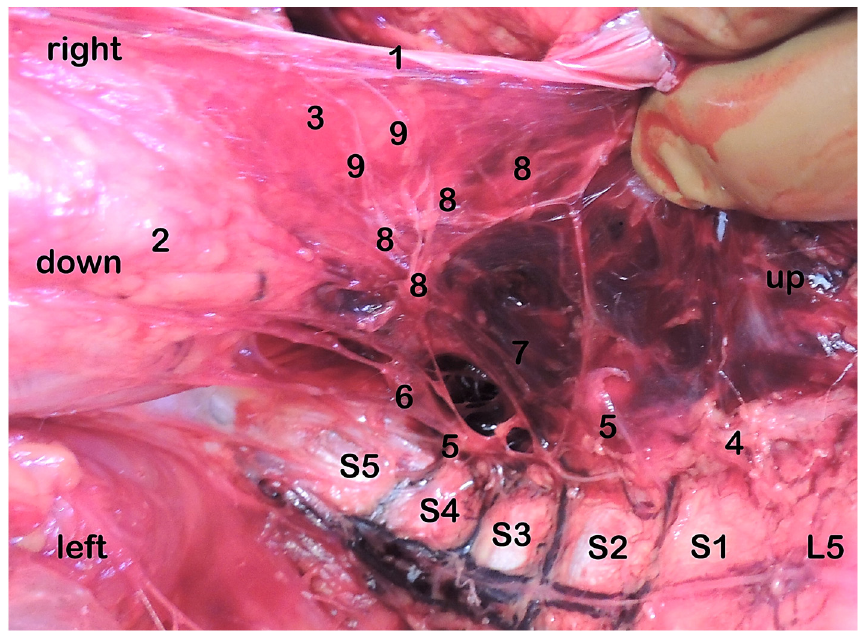
Figure 8. Pelvic plexus, front view, craniocaudal direction. Significant asymmetry of the pelvic plexus is observed. Peritoneum (1), rectum (2), bladder (3), truncus sympathicus (4), ganglia trunci sympathici (5), postganglionic sympathetic branches (6), pelvic splanchnic nerves (7), ganglia plexus pelvicus (8). Subperitoneal penetration of the branches of the plexus to the organs of the lesser pelvis (9).